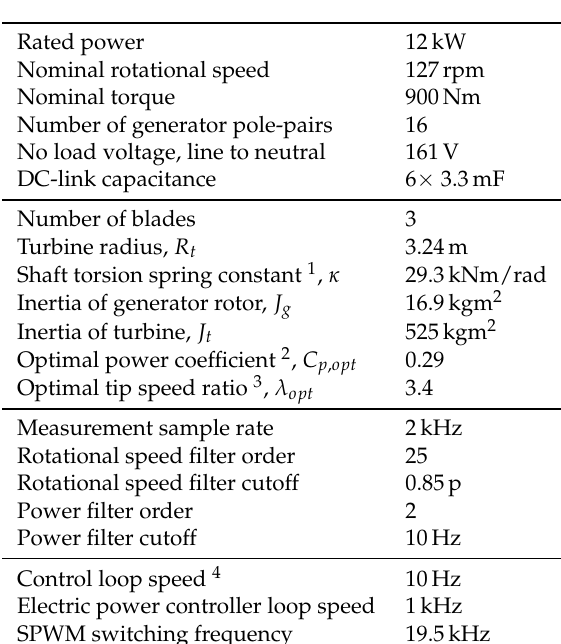
Table 3. System specifications.